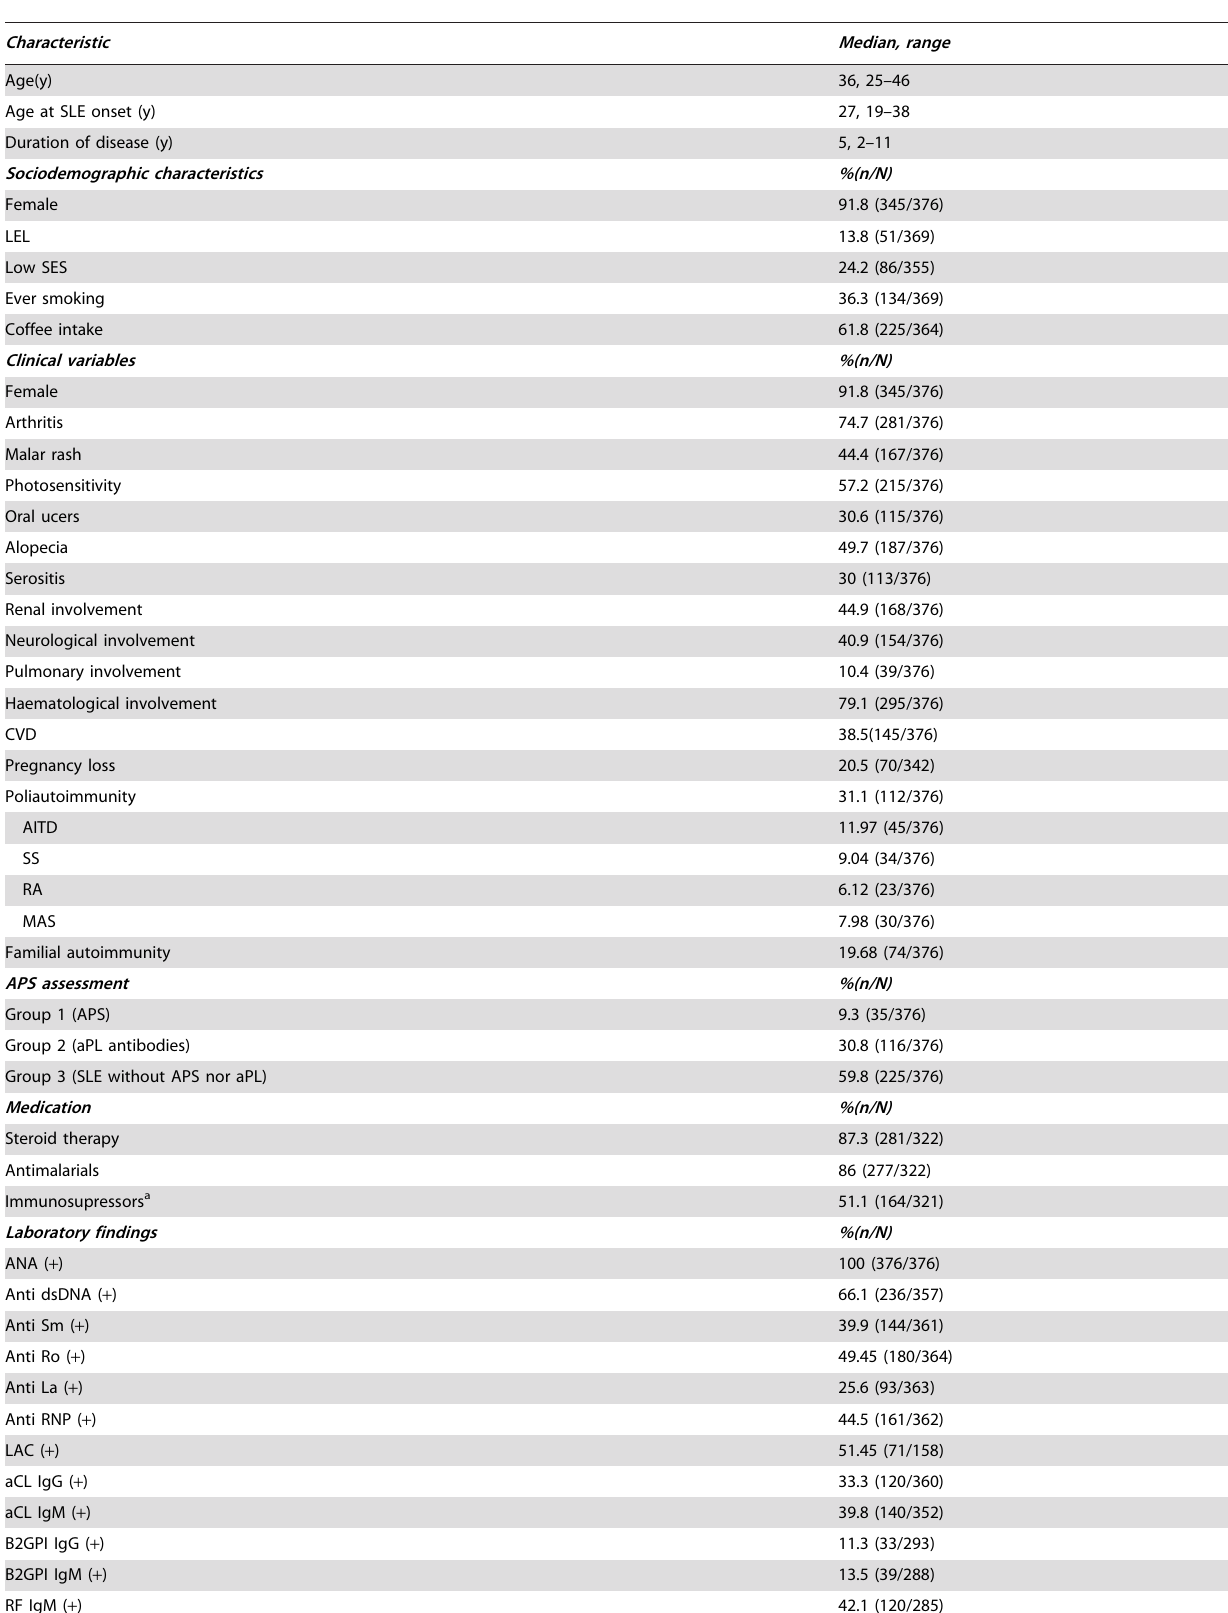
Table 1. Demographic and clinical characteristics of 376 patients with